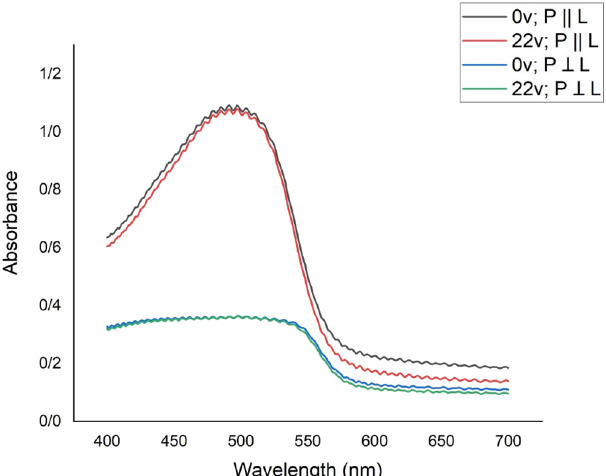
Figure 9. The plot of absorption spectrum in parallel and perpendicular polarization proportion to the alignment of sample at different applied voltages. Results show that as predicted in Fig. 6, applied voltage do not affect dye molecules’ reorientation.